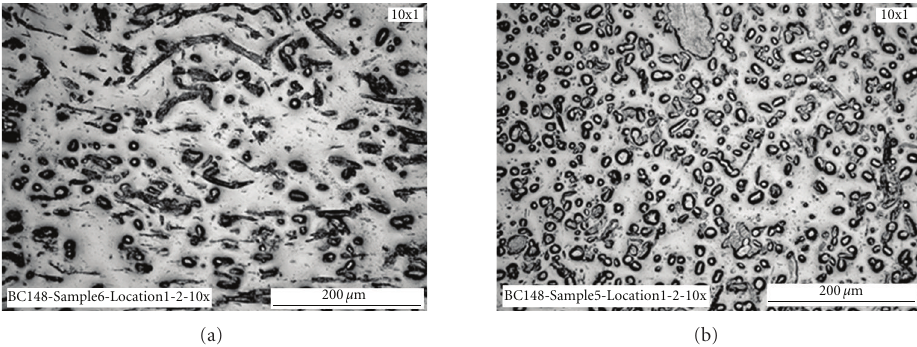
Figure 5: Optical microscopy images of cross-section of composite sample (a) along and (b) perpendicular to the flow direction.